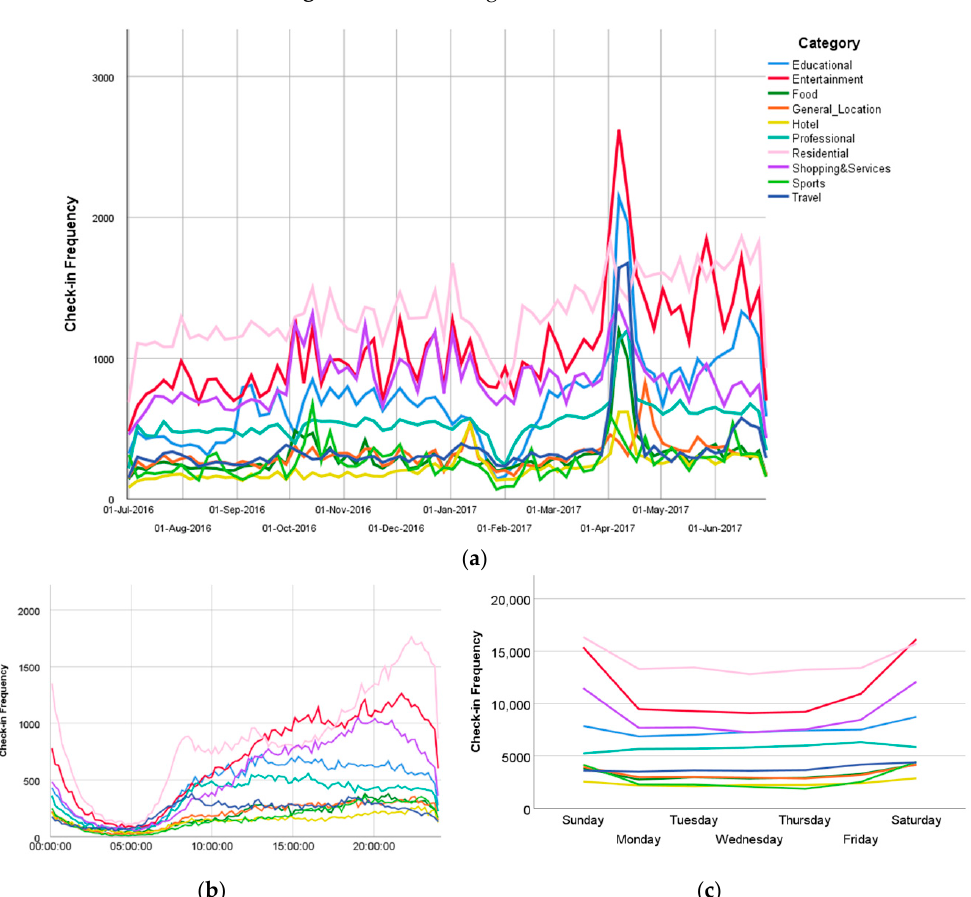
Figure 4. Venue categorization statistics.